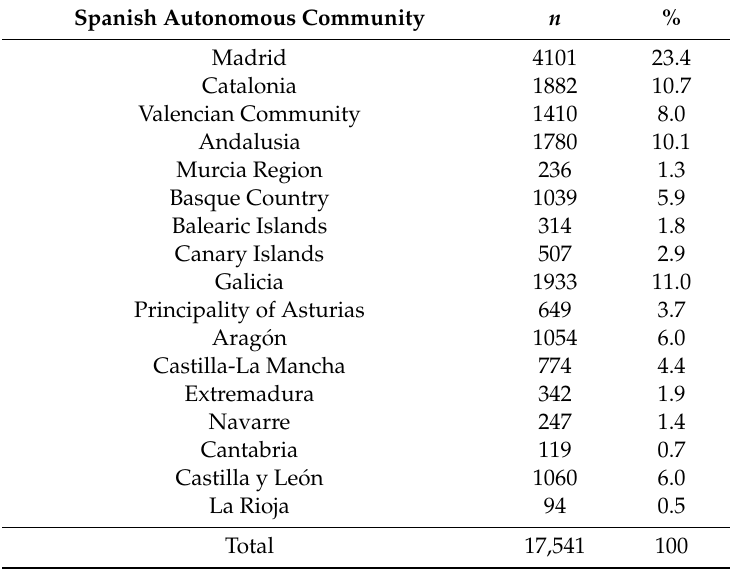
Table 1. Sample distribution into Spanish Autonomous Community (SAC) ( n =